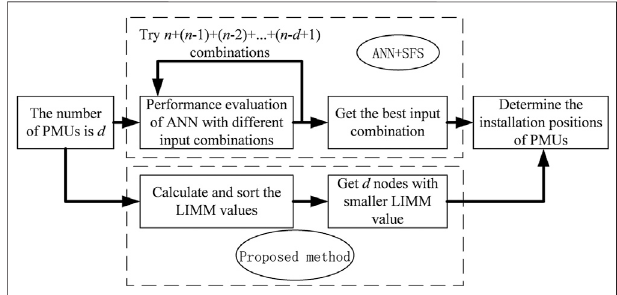
FIGURE 2 | Comparison of PMU location